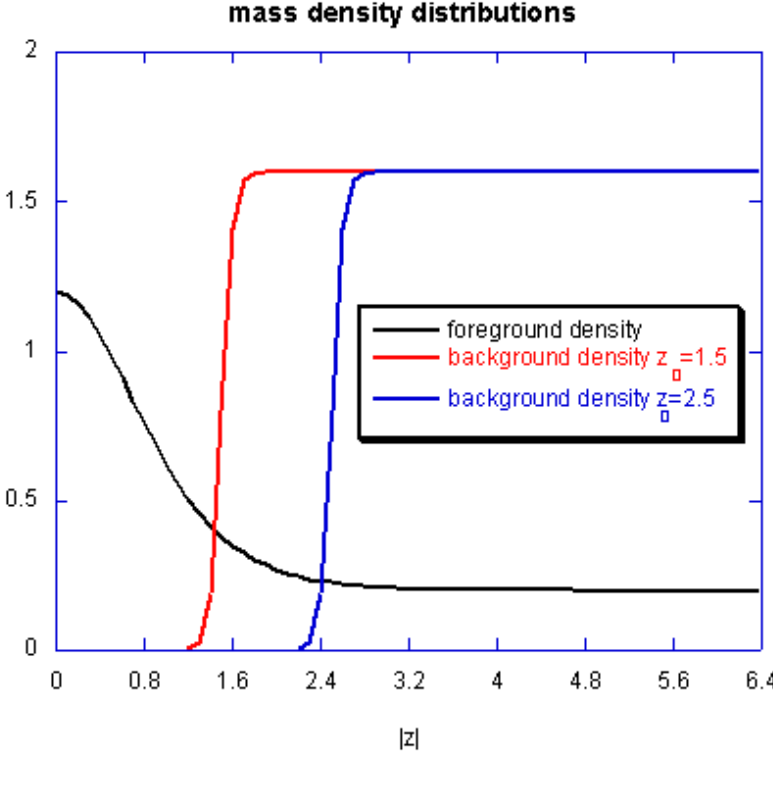
Fig. 1. Plot of the initial mass den- sity distribution. The foreground hot plasma density is denoted by the black curve. Background mass densities of ei- ther oxygen or protons are added at the locations indicated by the blue and red